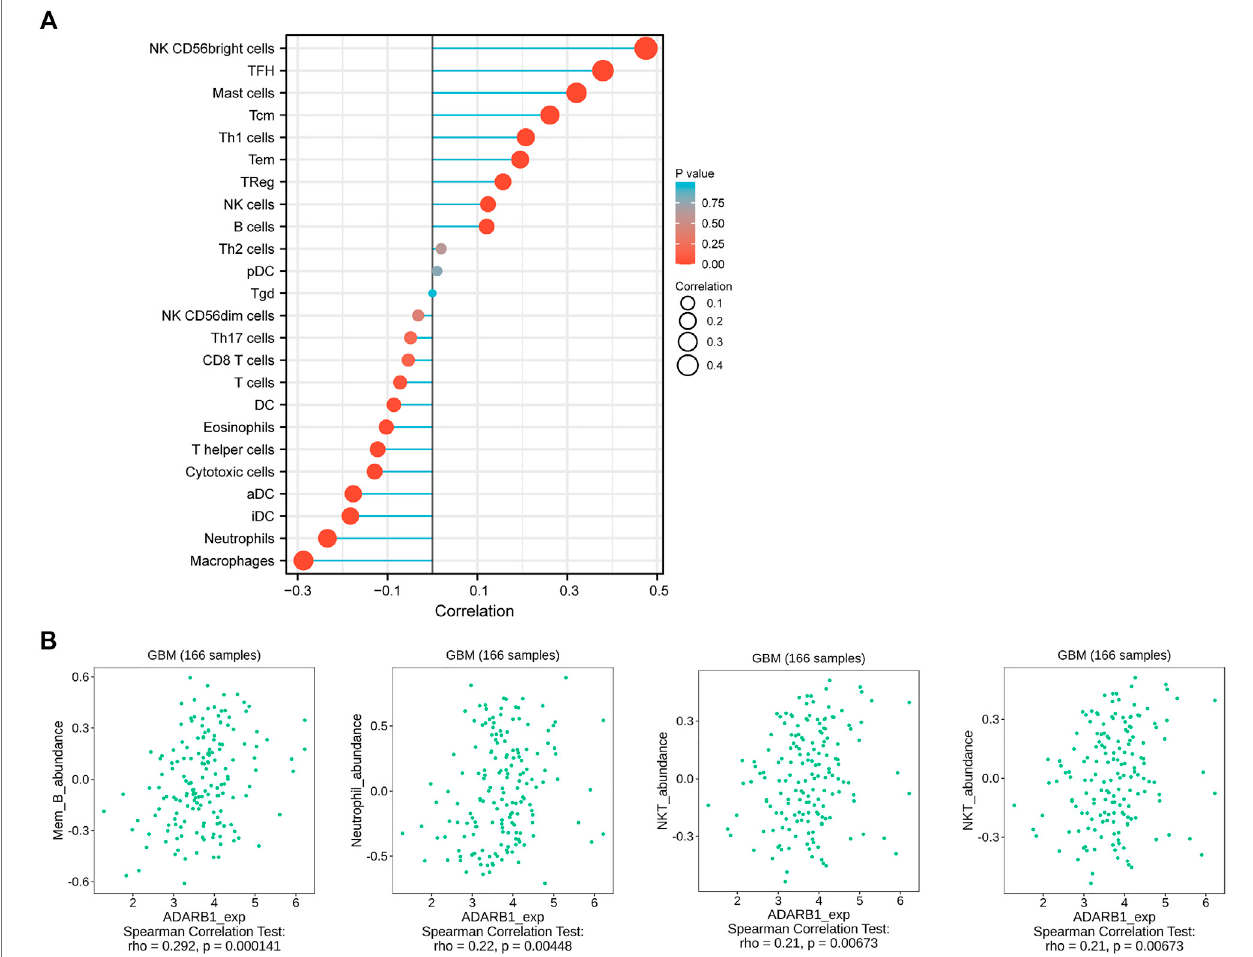
FIGURE 5 | Regulation of immune molecules by ADARB1. (A) The bubble diagram analyzed by ssGSEA showing the correlation between ADARB1 and immune cells. (B) The correlation of ADARB1 expression with tumor-in fi ltrating lymphocytes (TILs) in GBM patients from TISDIB database. (C – E) The association between the expression level of ADARB1 and three immune checkpoints B7-H3, CTLA4 and PD-L1 from GEPIA database. (F – I) The expression of ADARB1 and immune molecules in primary and recurrent tumor of GBM patients using qPCR.